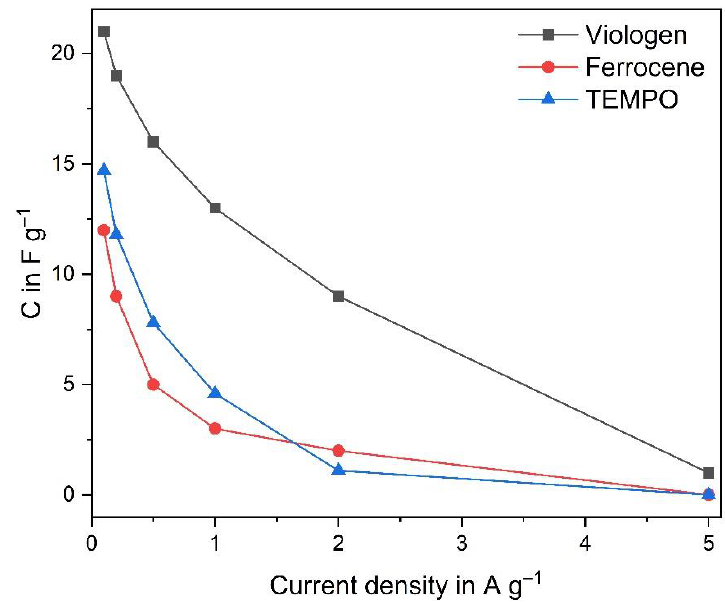
Figure 6. Rate capability of 0.1 M RAILs in Pyr 14 TFSI from 0.1 to 5 A g − 1 in symmetrical full-cell setup with AC electrodes.